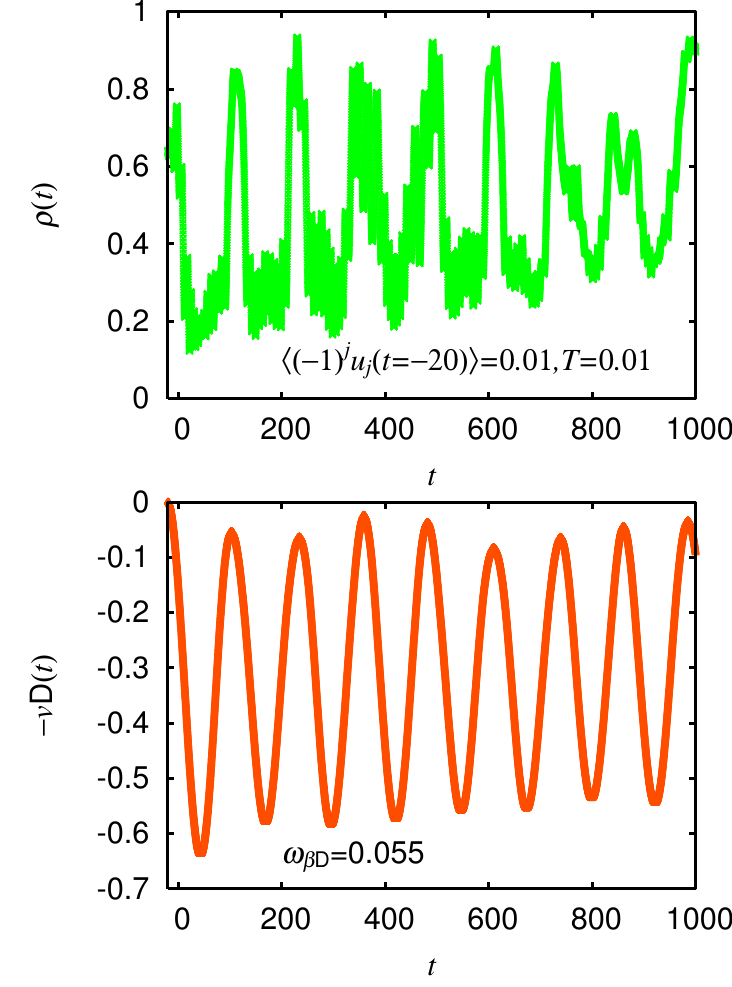
( t ) with bare energy ω Figure 4. Transient ionicity ρ ( t ) (upper), displacement − v = 0.055 D β D ( t ) (cid:105) with bare energy ω (middle), and dimerization (cid:104) ( − 1) j u = 0.013 (lower) after setting j α ( t = − 20) = 0 . 01 , adding random numbers ( T = 0.01) to initial dimerization ( − 1) j u j phonon variables as explained in text, and charge-transfer photoexcitation of neutral phase using ω = 0.65, T = 10, and F = 4.2 in case of strong Peierls and Holstein couplings pmp pmp λ = 0.167 and λ = 0.20 From [28]. Reproduced with permission from α β